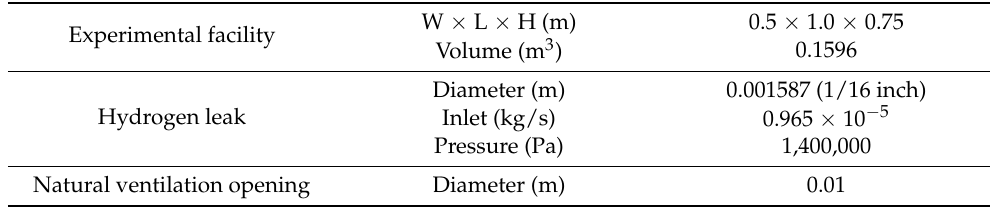
Table 2. Experiment